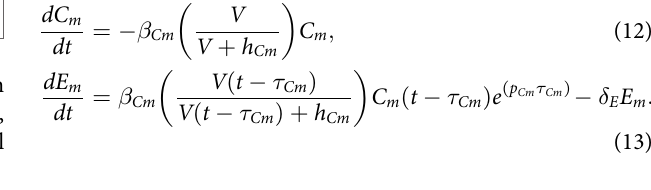
FIGURE 7 | Clinical influenza A (H7N9) data exhibit an exponential relationship between the average CD8 + T cell number and recovery time . The x-axis is the average level of functional effector CD8 + T cells (i.e., IFN γ + CD8 + T cells) over the period from day 8 to day 22 (or the recovery day if it comes earlier). Spearman’s rank correlation test indicates a significant negative correlation between the average CD8 + T cell numbers and recovery time ( ρ = (cid:0) 0.8368, p = 0.0013). Excluding one of the patients (No. a79 in Data Sheet S1 in Supplementary Material; discussed in Section 4), all other data points (solid dots) are fitted by an offset exponential function y = 24.8755e − 0.0073 x + 17.5356, indicating that the best achievable recovery time for individuals with a high CD8 + T cell response is approximately